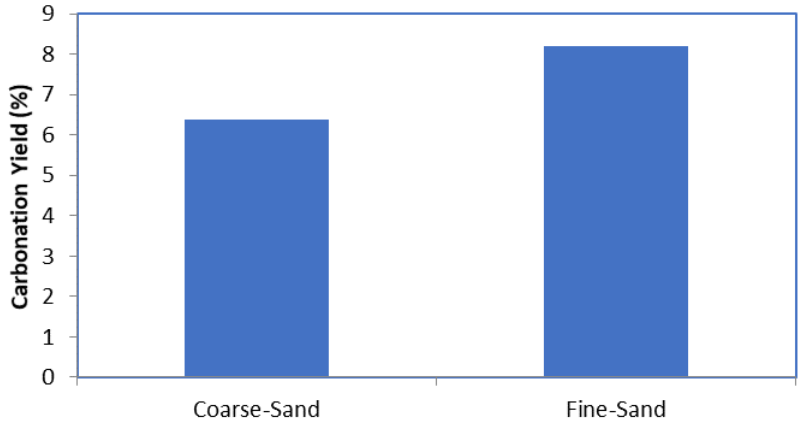
Figure 4. Carbonation yield at 5 bar pressure, 4 h carbonation time and 40 h curing time.